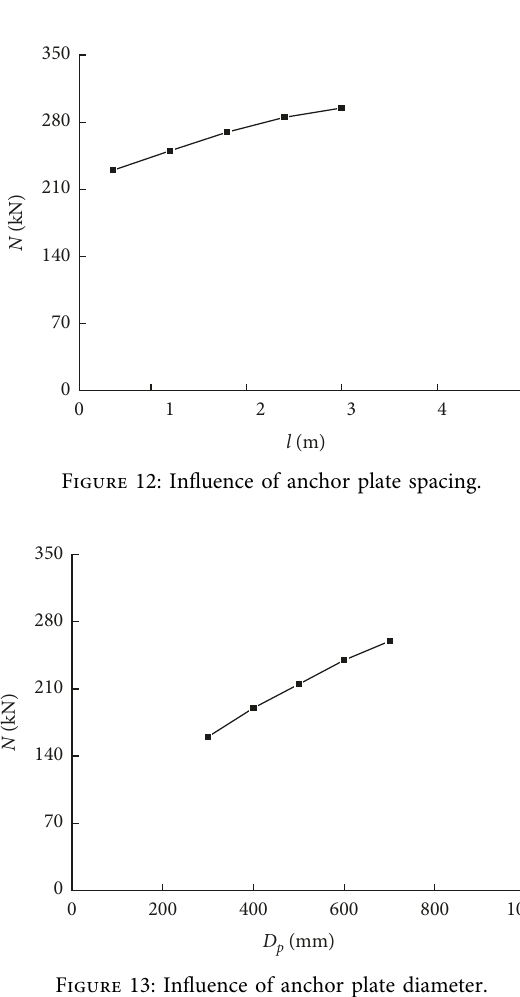
Figure 13: Influence of anchor plate